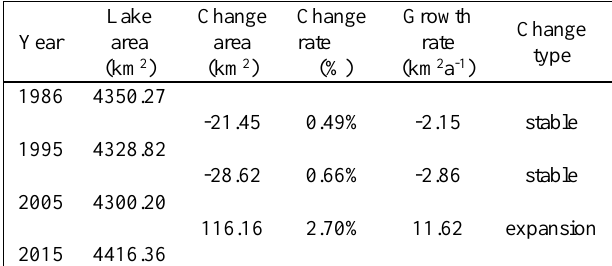
4.2.3 Lake Range Change Analysis in Selin Co : As shown in